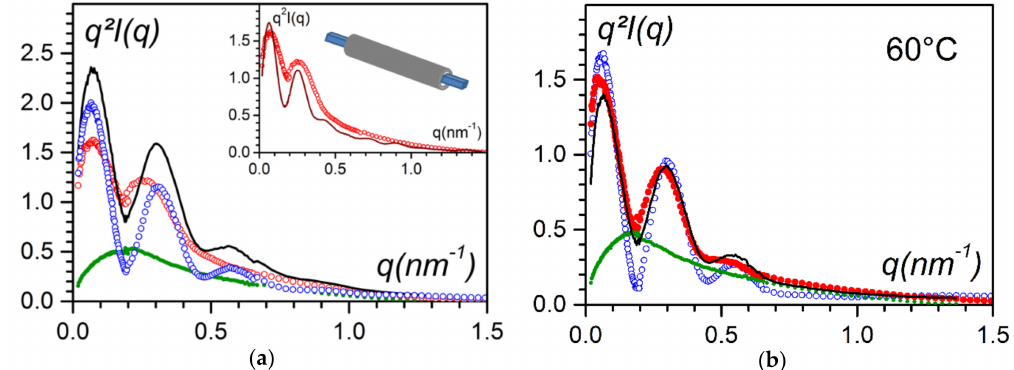
Figure 12. SANS curves plotted by means of a Kratky-plot, q 2 I(q) vs q. For both figures: = bhpb-10/trans- (cid:35) decahydronaphthalene; = hybrid system; = P3BT fibrils in trans-decahydronaphthalene; solid black (cid:35) line = sum of the scattering curves of the binary systems ( + ). ( a ) Results obtained at T = 20 ◦ C, inset fit (cid:35) of the scattering curve of the hybrid system with the model shown (blue = P3BT fibrils, grey = nanotube; see text for details). ( b ) Results at 60 ◦ C